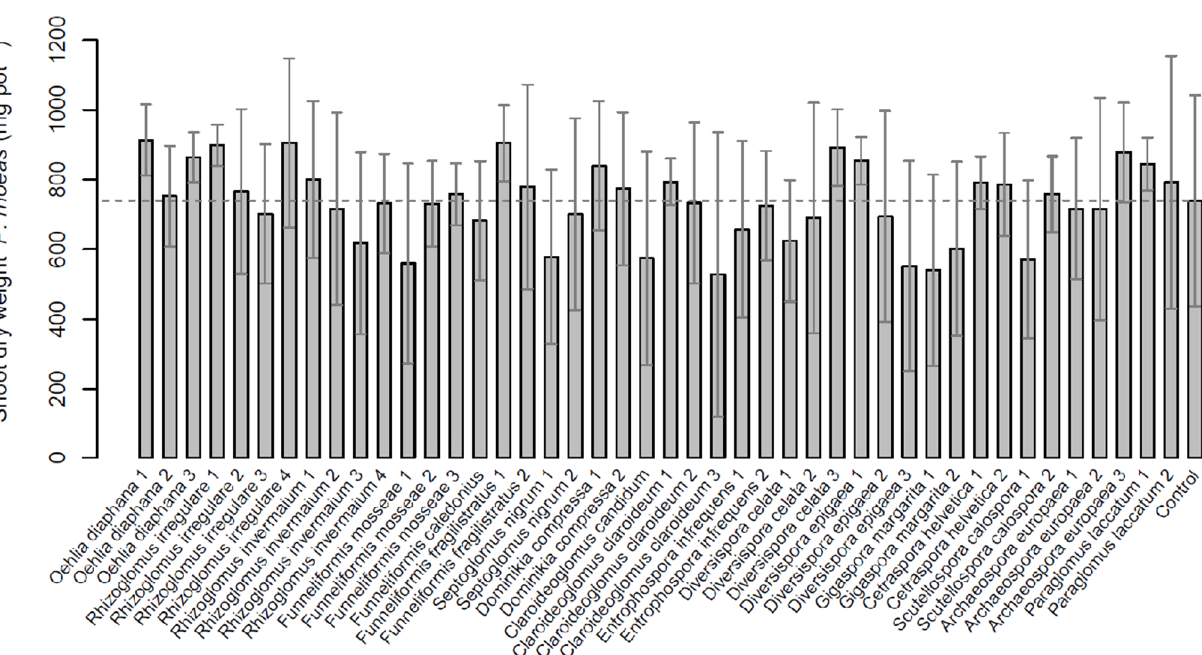
Figure 3. Aboveground dry mass of Papaver rhoeas inoculated with 44 different isolates of arbuscular mycorrhizal fungi (AMF) and one non-mycorrhizal control. Data are reported as means (n = 6) and their standard deviations. No significant differences among AMF isolates or the control treatment were detected via Conover’s all-pairs comparisons ( p < 0.05)..